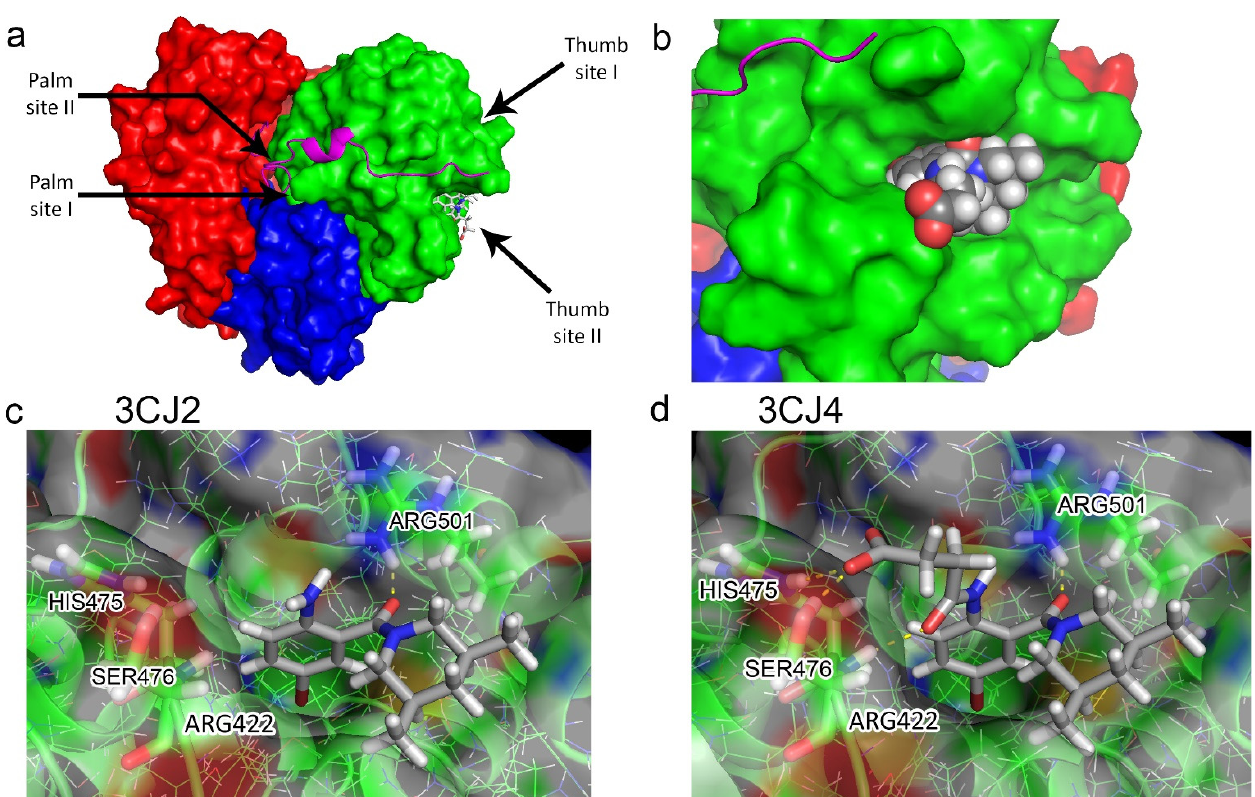
Figure 1. ( a ) Surface diagram showing the domains of the HCV NS5B protein [35,36]. ( b ) Location of the allosteric site II in the thumb domain of the HCV NS5B protein. ( c ) Binding pose of the drug candidate 3CJ2, with the bromine atom (brown) from the bromo-aryl moiety pointing towards the bottom of a non-polar pocket, and the amide oxygen interacting with Arg501. ( d ) Binding pose of the improved 3CJ4 drug candidate, in which all interactions from the parent are maintained. Succinic acid is added, which in turn undergoes polar interactions with other residues in the site. Pictures were generated using PyMOL [37].